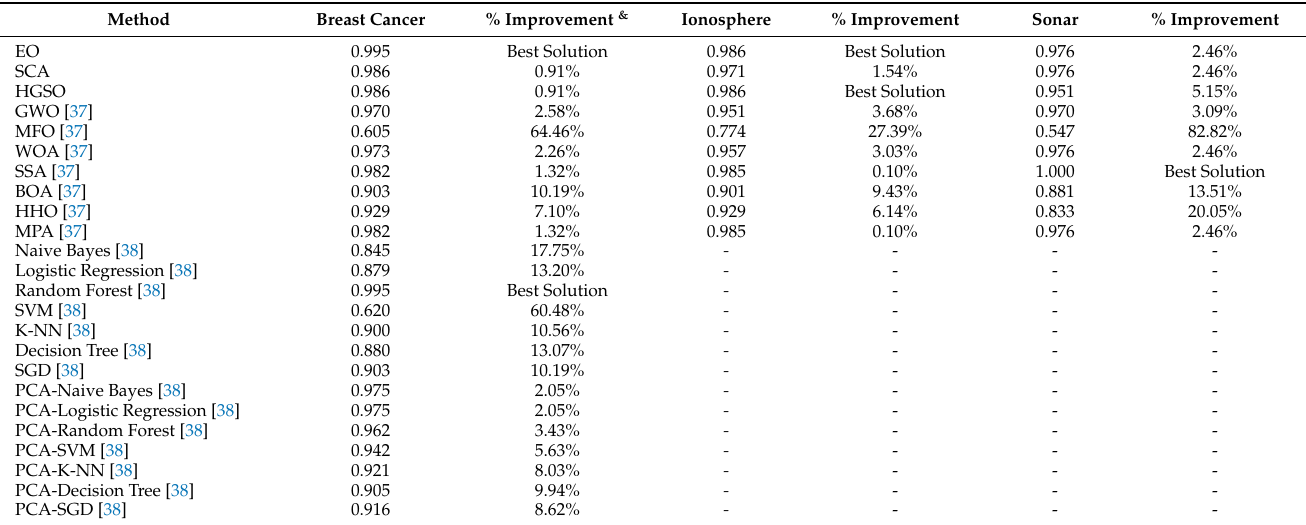
Table 7. Comparison of classification accuracy with literature results.